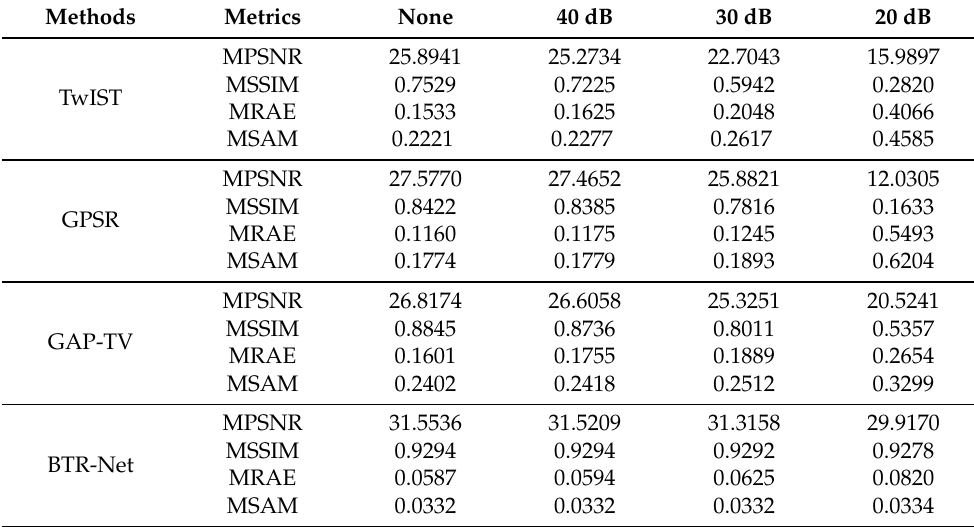
Table 3. Performance of different noise level (average of all test